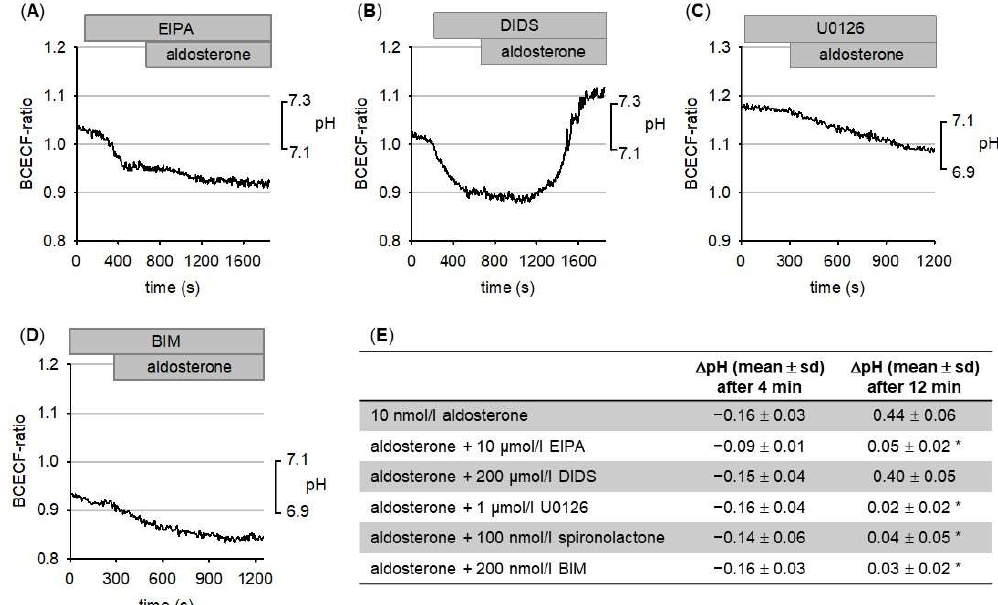
Figure 2. ( A ) The Na + /H + -exchange inhibitor EIPA prevents aldosterone-induced alkalinization. ( B ) Inhibition of HCO 3− - transporters with DIDS does not prevent aldosterone-induced alkalinization. ( C ) Aldosterone-induced alkalinization is abolished when ERK1/2-activation is prevented by U0126. ( D ) Aldosterone-induced alkalinization is abolished by PKC inhibition with BIM. ( E ) Summary of the pH-changes under the different conditions. N = 60–100 for each condition. * = p < 0.05 versus control.